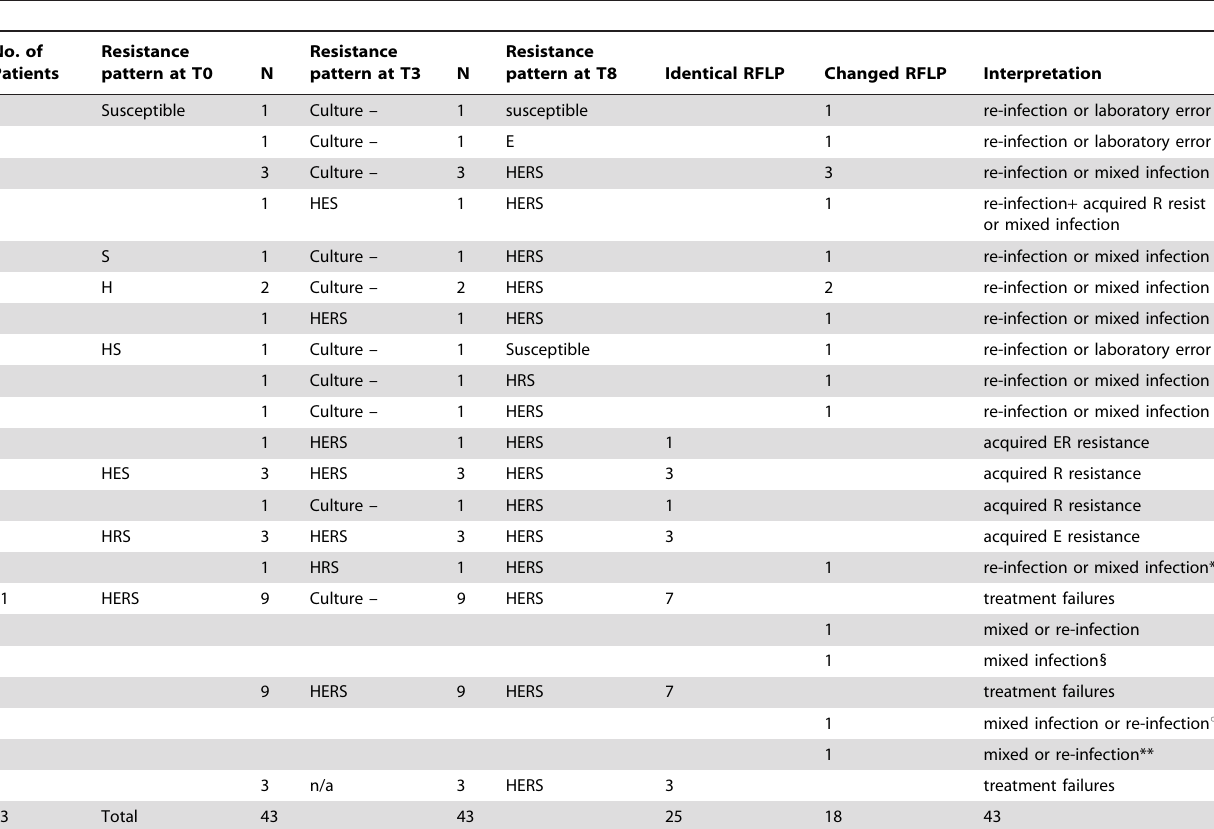
Table 4. Drug susceptibility testing results before the start (T0), after 3 months (T3), and at the end of treatment (T8) for patients remaining culture positive at the end of a full treatment course with comparison of RFLP results at T0 and T8.